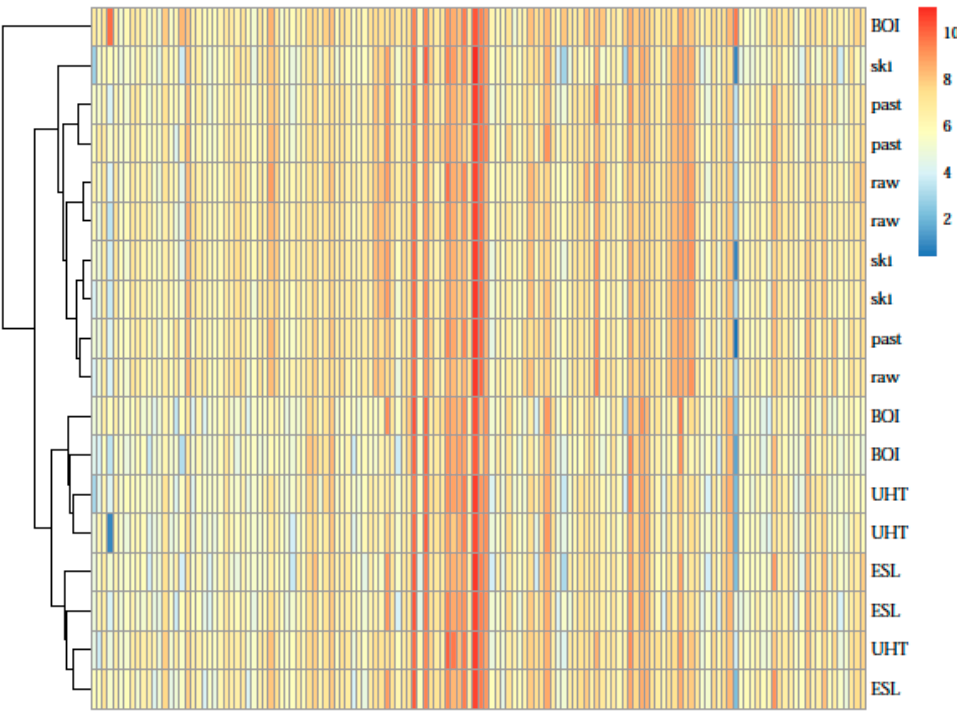
Figure 3. Heat map for protein levels and milk types. Rows reflect individual samples, whereas individual proteins are given in columns. Their LFQ values are represented by different colors according to the color code from low (blue) to high (red) expression.